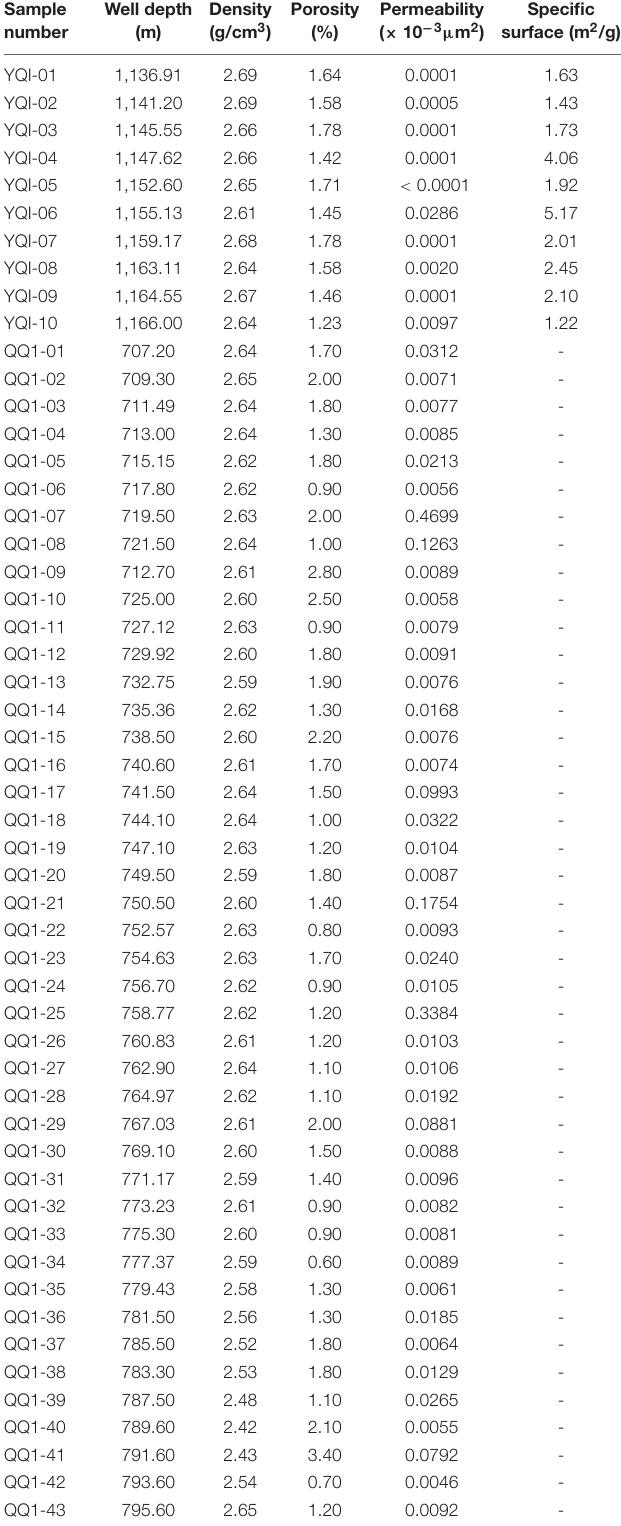
TABLE 4 | Density, porosity, permeability, and specific surface area of the Longmaxi Formation shale in different wells. Sample